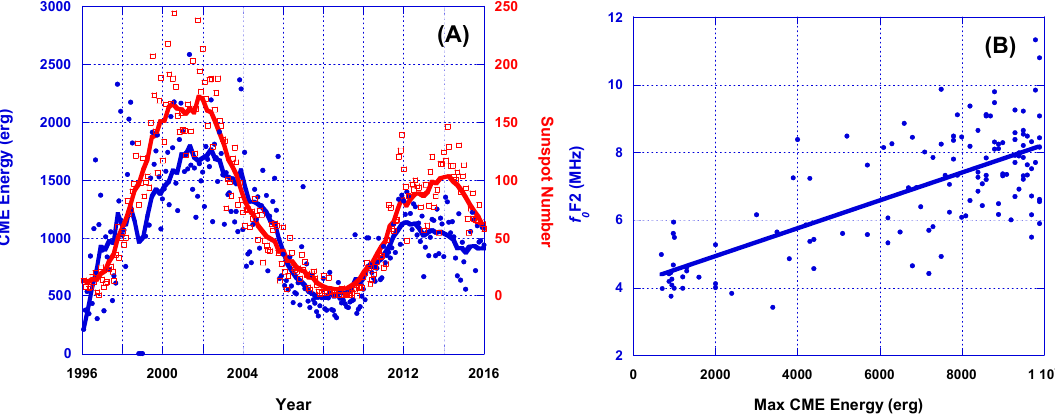
Figure 3. The time series of the monthly average values CME energy (in erg) and that of sunspot numbers (SSN) during the period 1996–2013 ( A ), and the relationship between F values and the monthly maximum CME energy ( B ). The blue color of the left axis values, smooth curve and round points of plot ( A ) refer to the f 0 F2, while the red color of the right axis values, smooth curve and square points denote to the sunspot numbers.